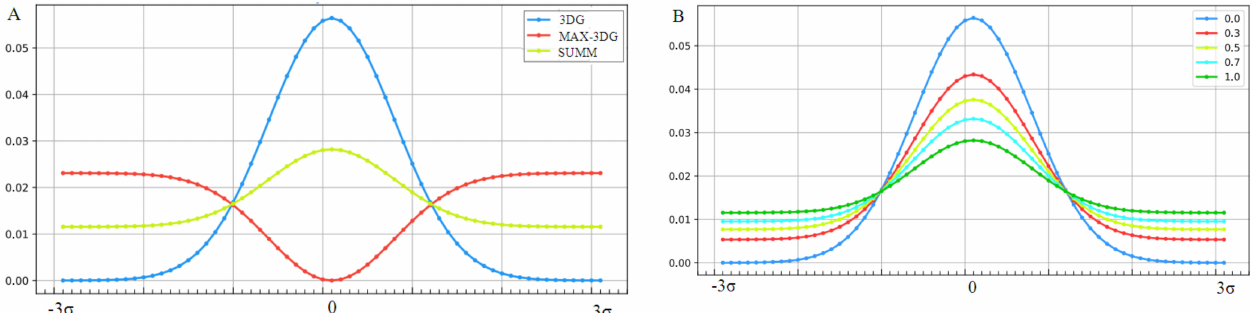
Figure 11. Changes in the form of the external force field that determine the environmental characteristics of the folding protein. ( A )—Successive stages of force field modification: blue line, field expressed by 3D Gauss distribution (3DG); red line, “inverted” field preferring the exposure of hydrophobic residues on the surface (MAX-3DG); green line, resultant field for the derived field consensus from water and medium is the disturbing field (SUMM) for K = 1. An example of the